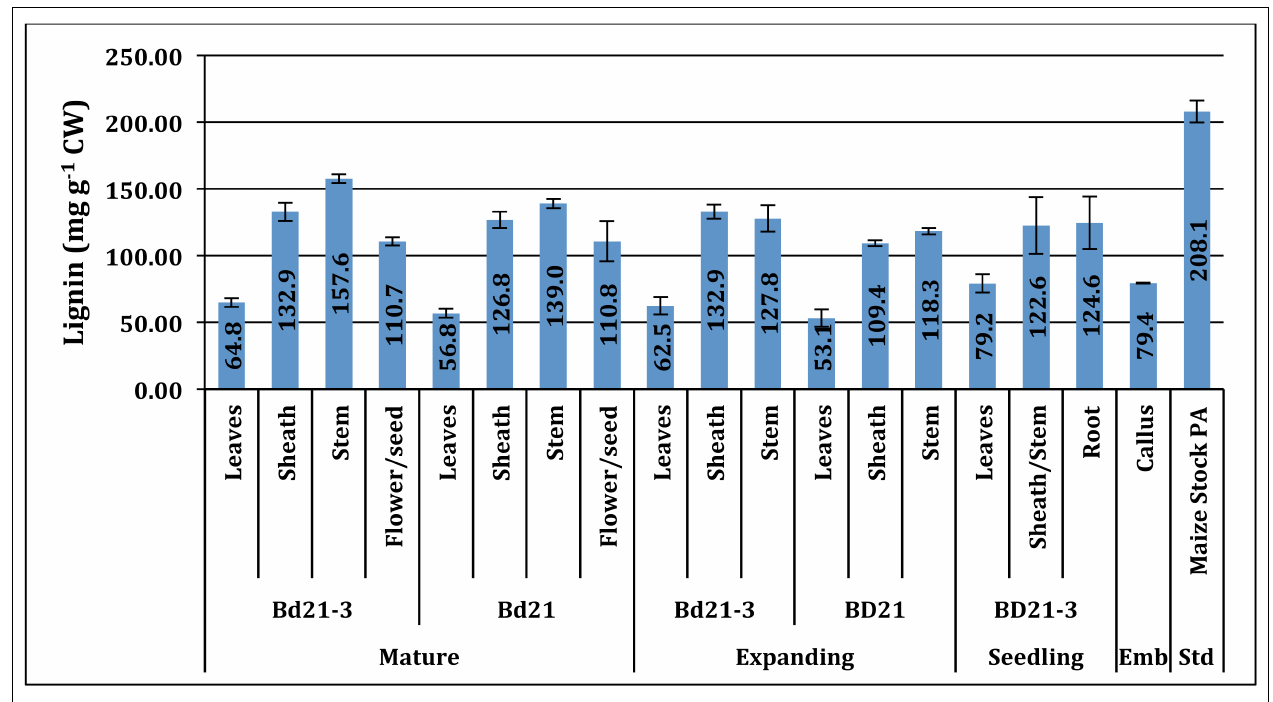
FIGURE 2 |Acetyl bromide lignin (mg g − 1 CW) of developing Brachypodium cell walls across developmental stage, accession, and tissue. Std, positive assay standard; Emb, embryonic. Error bars represent the standard deviation from two independent tissue harvests.